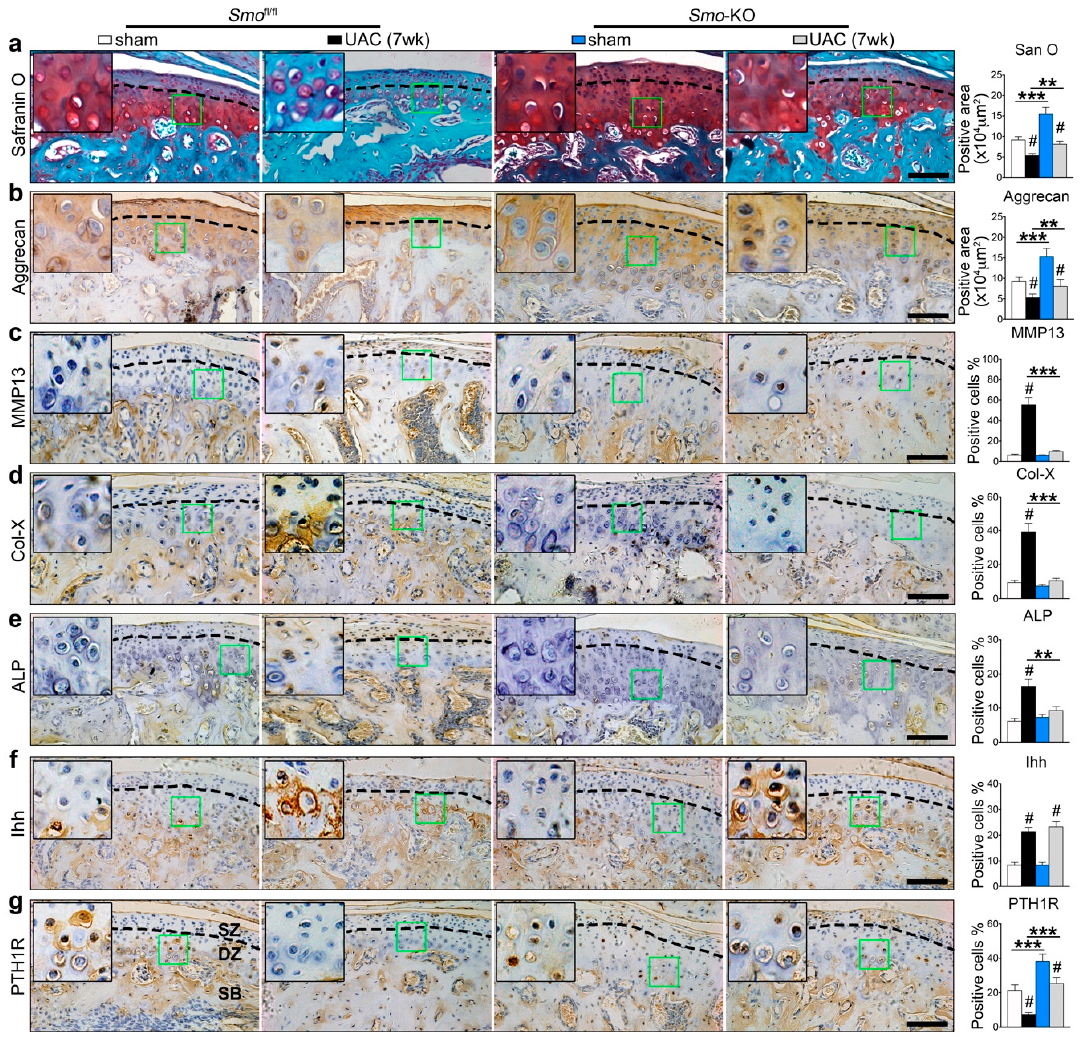
Figure 4. Reduced cartilage matrix and enhanced terminal di ff erentiation in UAC group were reversed by inhibiting Ihh signaling through deleting Smo . Cartilage-specific and tamoxifen-inducible Smo gene knockout ( Smo -KO) mice were used. The Smo fl / fl mice were used as the genetic control. UAC was applied to 6-week-old mice for 7 weeks. Safranin O staining ( a ), immunohistochemical staining of aggrecan ( b ), MMP-13 ( c ), Col-X ( d ), ALP ( e ), Ihh ( f ), and PTH1R ( g ) and the quantitative data (right panels) are presented. The green box regions in the images were magnified at the top left corner. Black dotted lines distinguish the superficial and deep zone chondrocyte. SZ , superficial zone. DZ , deep zone. SB , subchondral bone. Magnification, 200 × . Scale bar, 100 µ m. n = 6. Results are represented as the mean ± SD. ** p < 0.01, *** p < 0.001 for the di ff erences between Smo -KO group and Smo fl / fl control group. # p < 0.05 for the di ff erences between the sham and UAC group.